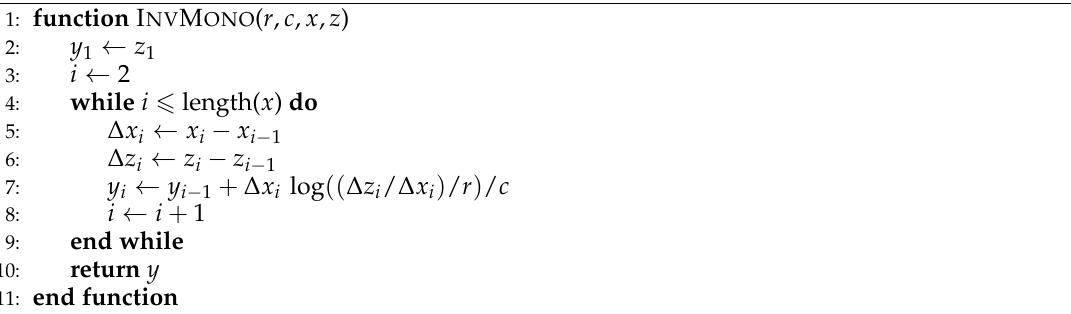
Algorithm 2 Pseudo-code to implement the (inverse) transformation